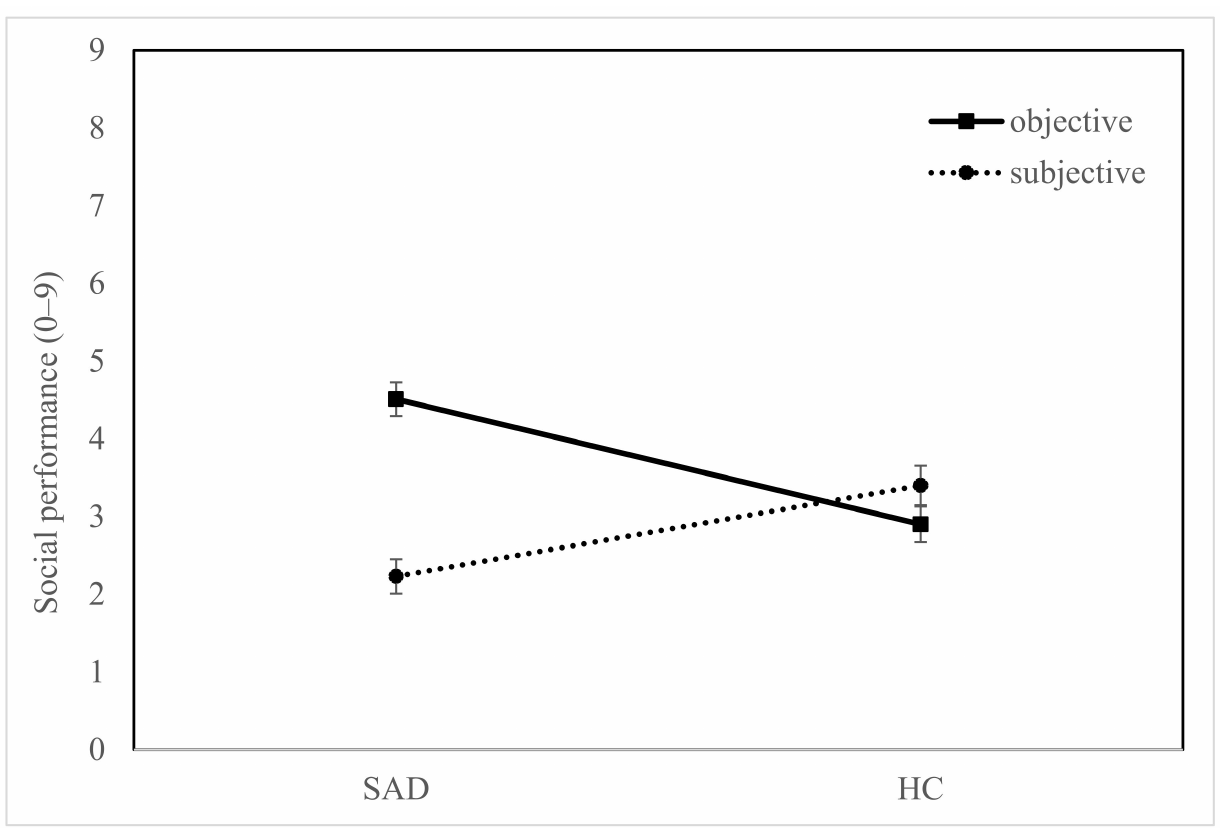
Figure 3. Social performance differences between children with SAD and HC and objective and subjective